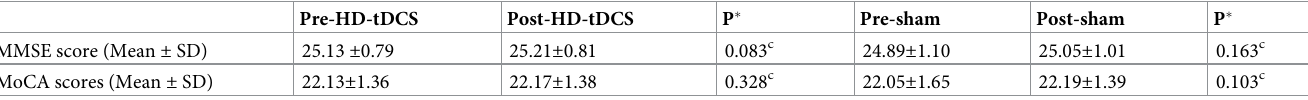
Table 2. The results of the neuropsychological assessment pre-post intervention in both MCI